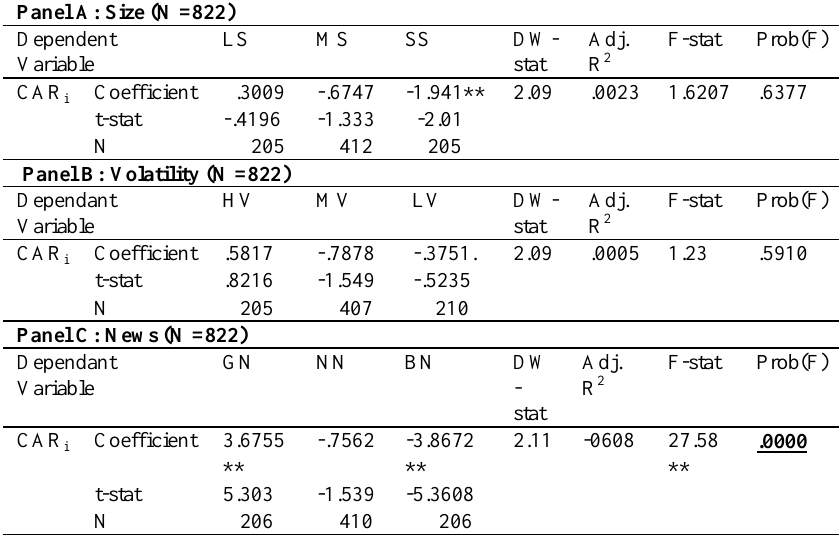
Table 6: Results for individual size, volatility and asymmetry or news effect Panel A: Size (N